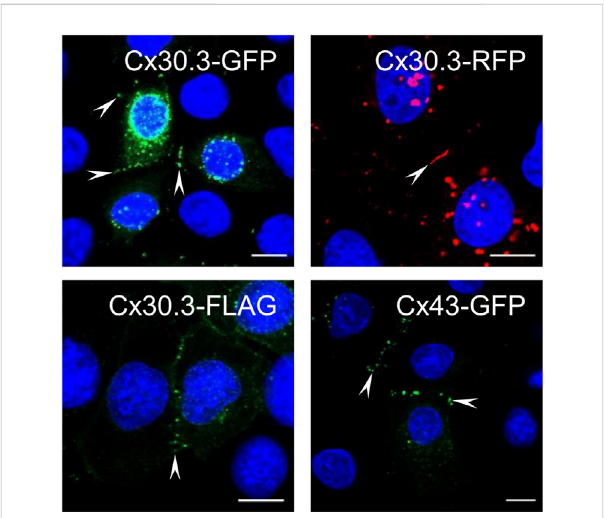
FIGURE 1 Cx30.3traf fi csandassemblesintogapjunctionsinkeratinocytes. GFP- (green), RFP- (red), and FLAG-tagged (green) wild type Cx30.3 assemble into gap junction plaques (arrowheads) at cell-cell interfaces in Cx43KO REKs similar to GFP-tagged Cx43 (green). Nuclei are demarcated by Hoechst 33342 staining (blue). Scale bars = 10 μ